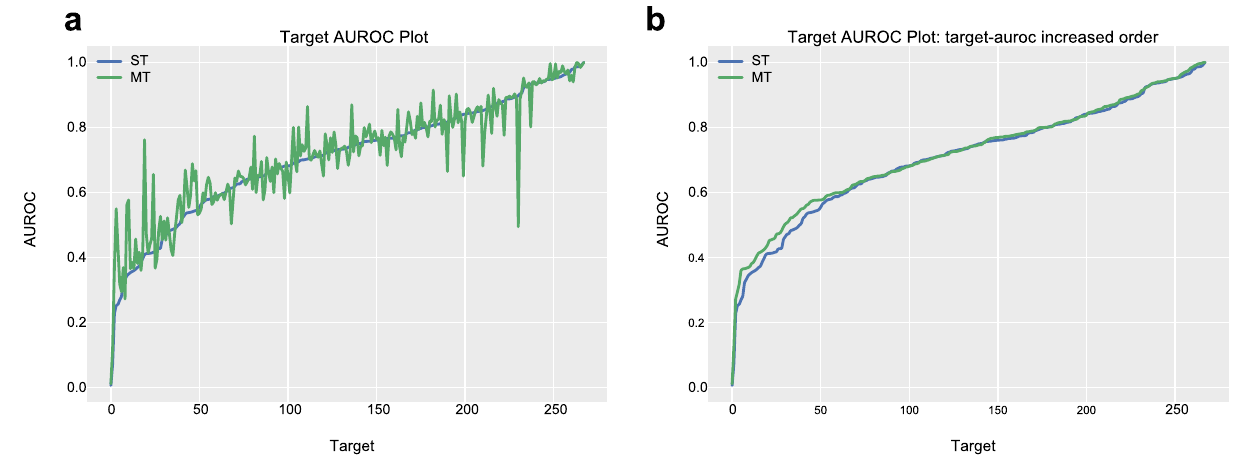
Figure 2. AUROC plot for the single-task learning model and multi-task learning model on similar targets. The blue line is a plot for the single-task learning model (ST), and the green line is a plot for the multi-task learning model (MT). ( a) The target order is the same in the two plots, ( b) the target orders of the two plots differ. The targets are sorted in target-AUROC increasing